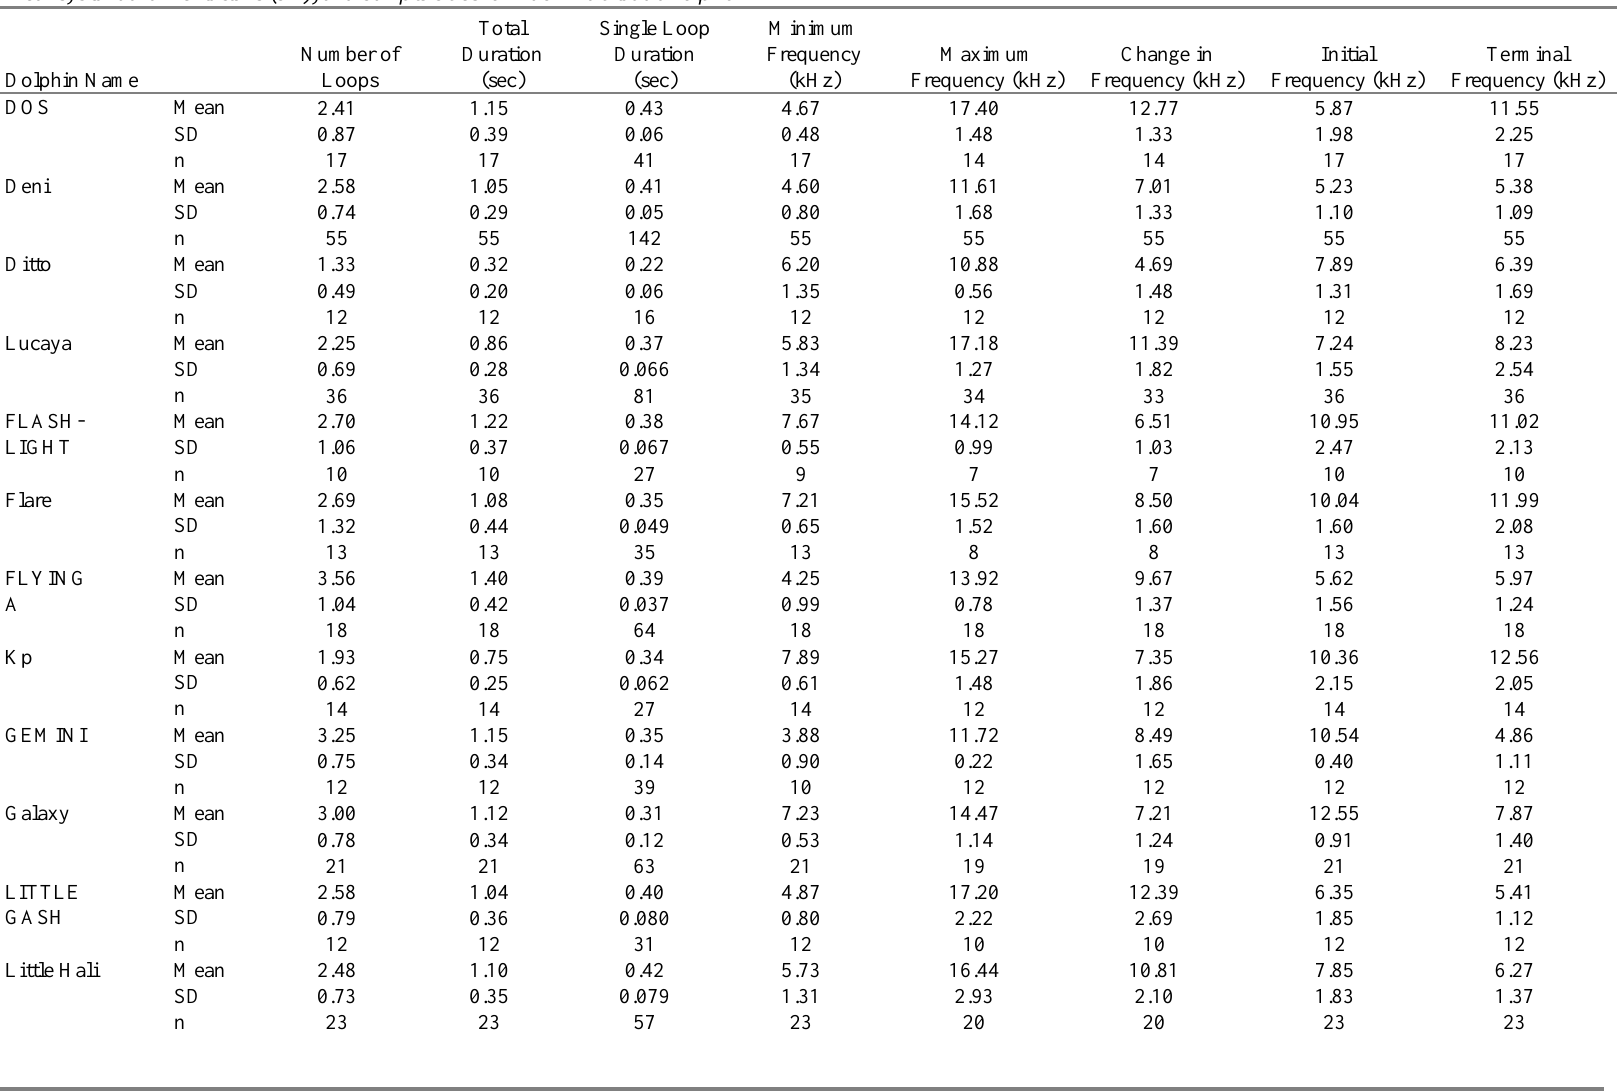
Means, Standard Deviations (SD), and Sample Sizes for Each Individual